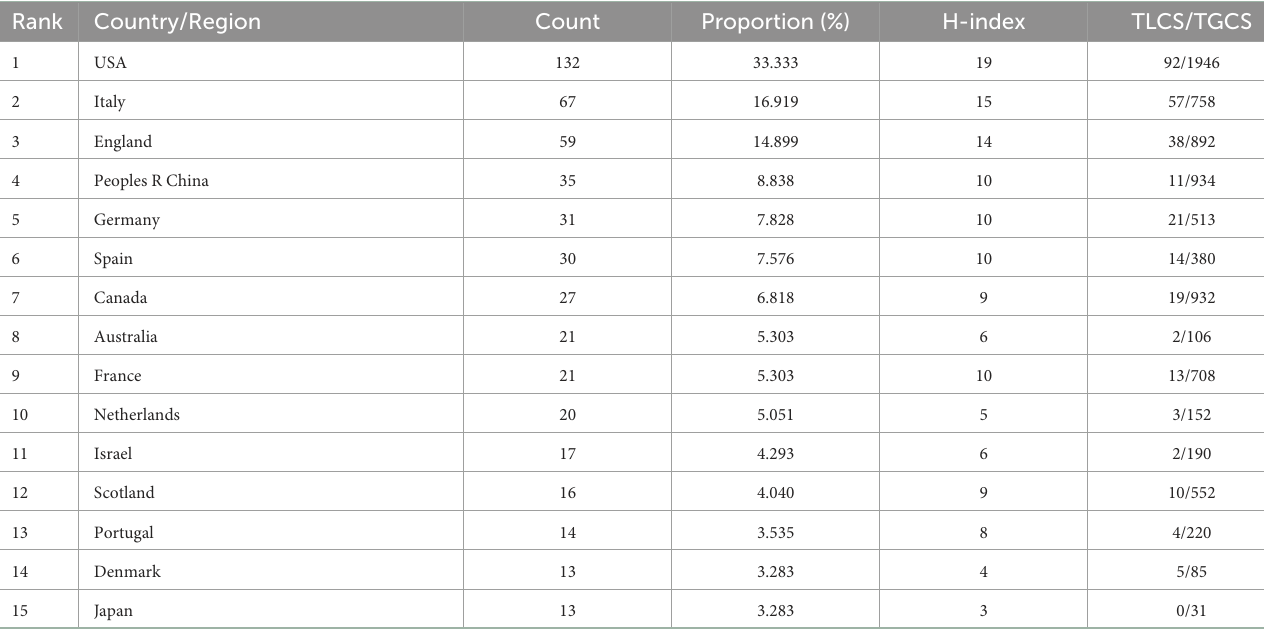
TABLE 1 The top 15 countries/regions in terms of publication volume. Country/Region